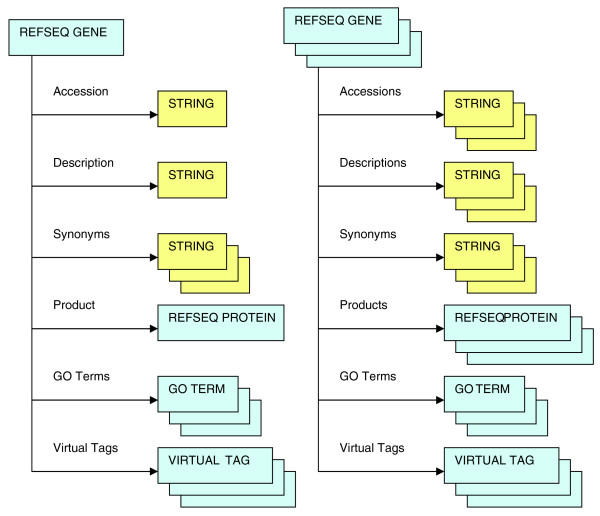
A diagram depicting two RDF graphs. The color yellow represents literal nodes and the color blue represents resource nodes. The capitalized text denotes the data type of each node. The arrows represent properties connecting the subject resource to object nodes, each with its own label. The left hand graph represents an individual RDF resource and its properties. Note that some properties have a single object whereas some have multiple objects. The right-hand graph represents a parallelization of the left-hand graph. Instead of a single subject node it has a root set of subject nodes, and properties follow to the objects of all subjects. Notice that the properties that were singular in the left-hand graph are now plural, and have multiple objects.